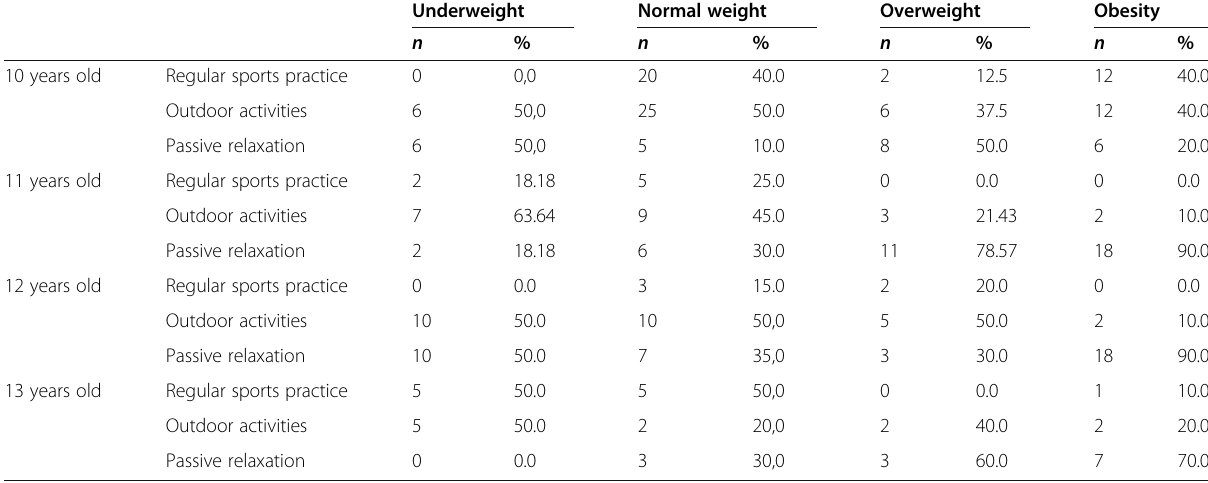
Table 14 The way of spending free time in a group of boys depending on age and BMI level (underweight, normal weight, overweight, obesity) Underweight Normal weight Overweight